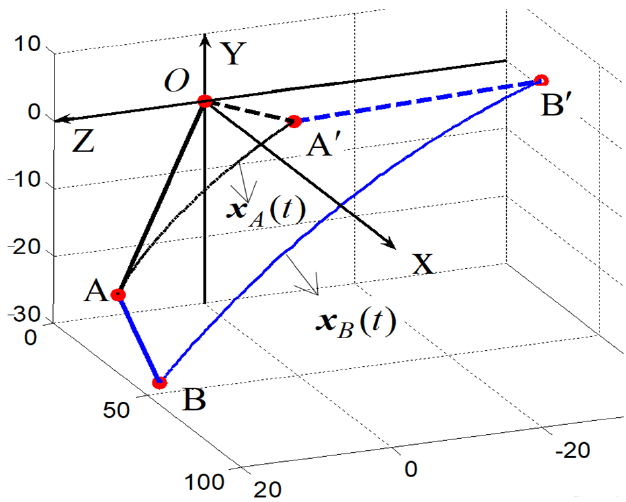
Figure 11. The posture and endpoint trajectories under the action of controller.